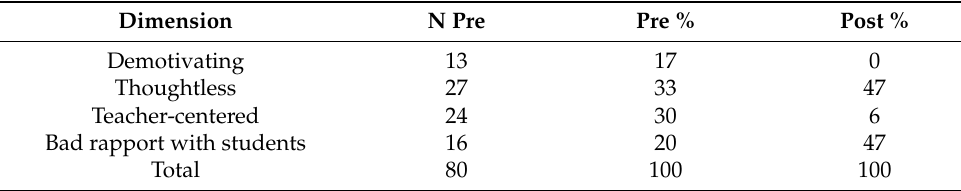
Figure 2. Barriers to attitudinal improvement in teachers. Table 3. Barriers to attitudinal improvement in teachers.